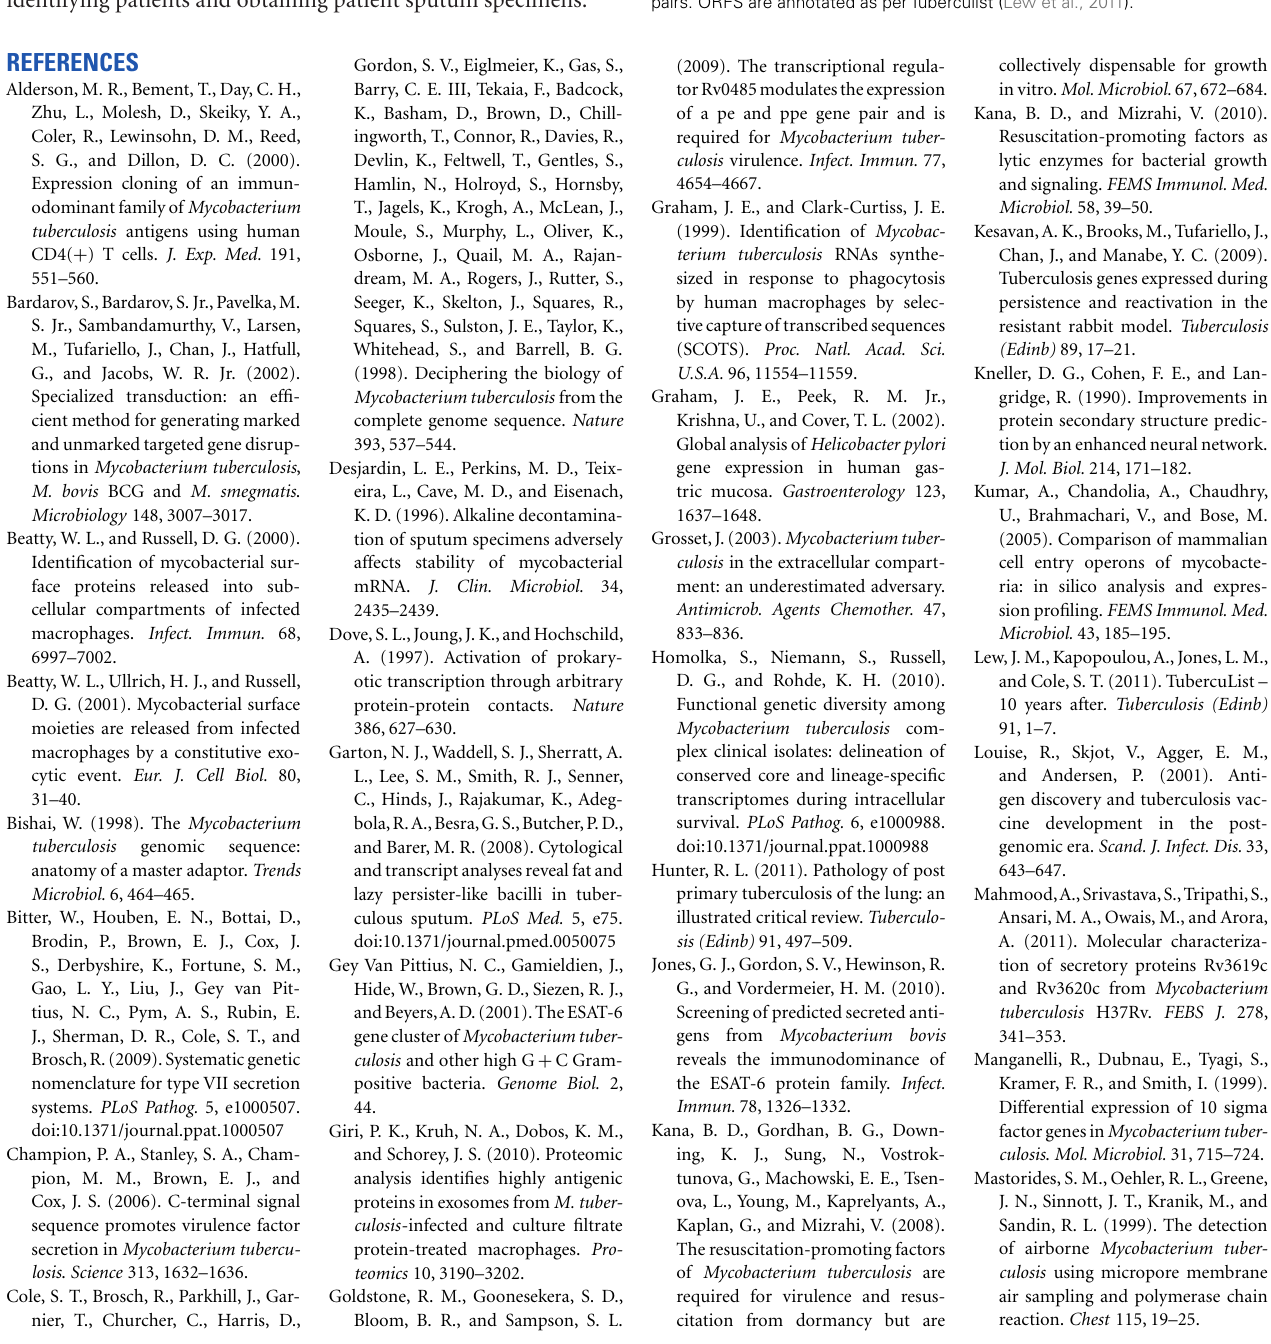
Table S1 | Highly expressed mRNAs in sputum bacteria. Table shows a list of H37Rv array features that were detected as expressed by hybridizing SCOTS cDNAs probes from bacteria in at least four or five patient sputum specimens. ORFs highlighted in green are those whose mRNAs were not detected (3 × over background) by conventional first-strand cDNA probes from H37Rv in standard mid-log shaking broth cultures.Those in blue encode QILLS–Mtb9.9 family pairs. ORFS are annotated as perTuberculist (Lew et al.,